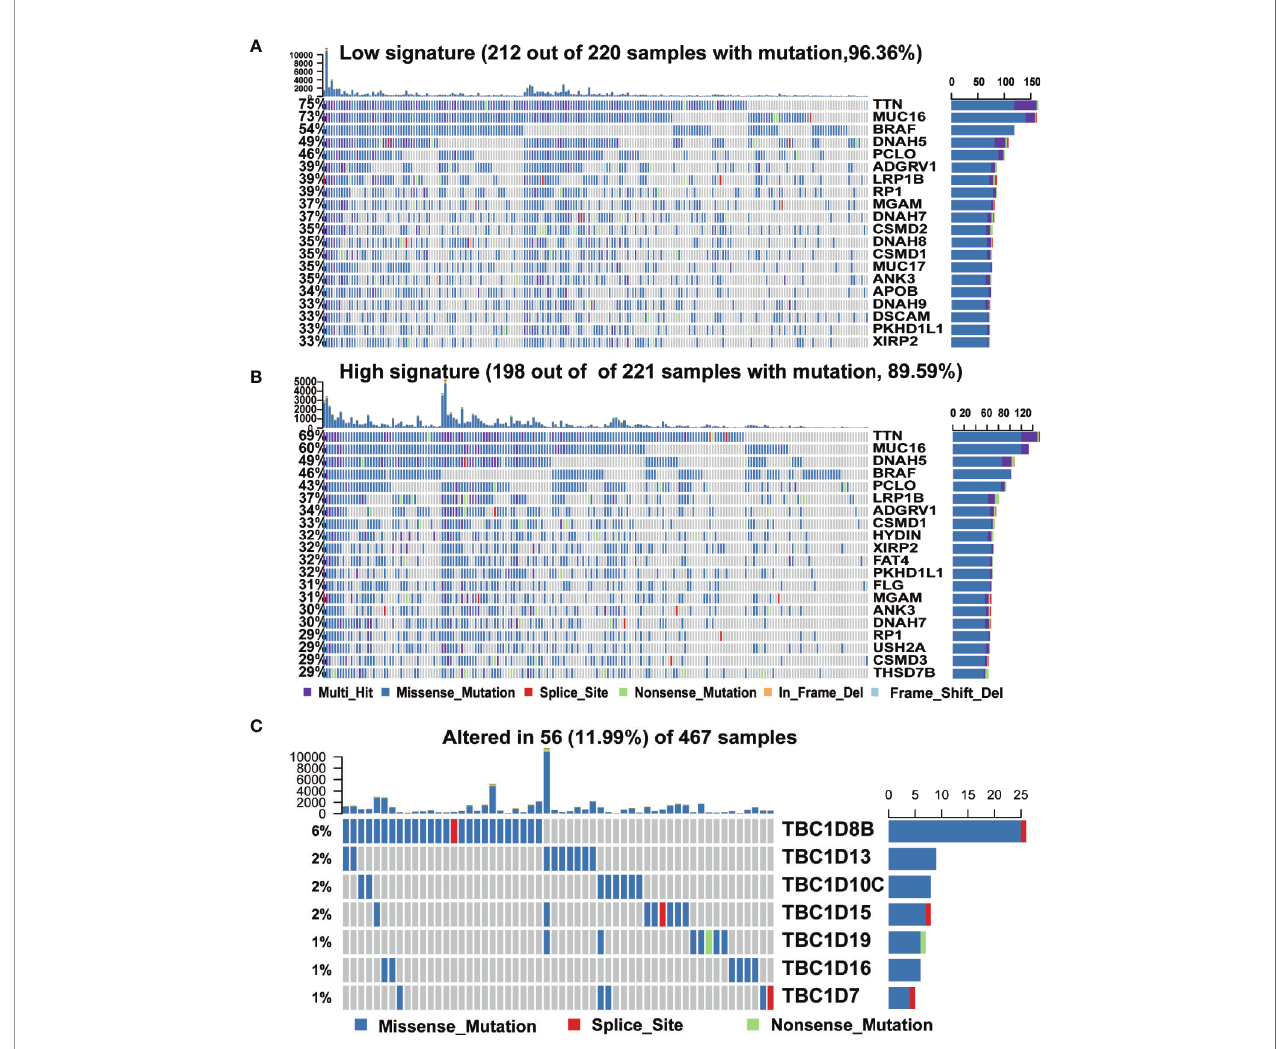
FIGURE 4 | The mutation frequency of top 20 genes and seven prognostic TBC genes in melanoma. (A, B) . Mutated oncogenes in melanoma were distributed into low and high risk-score subgroups. The mutation frequency of top 20 genes. (C) . Frequency of the seven prognostic TBC genes in total samples from the TCGA